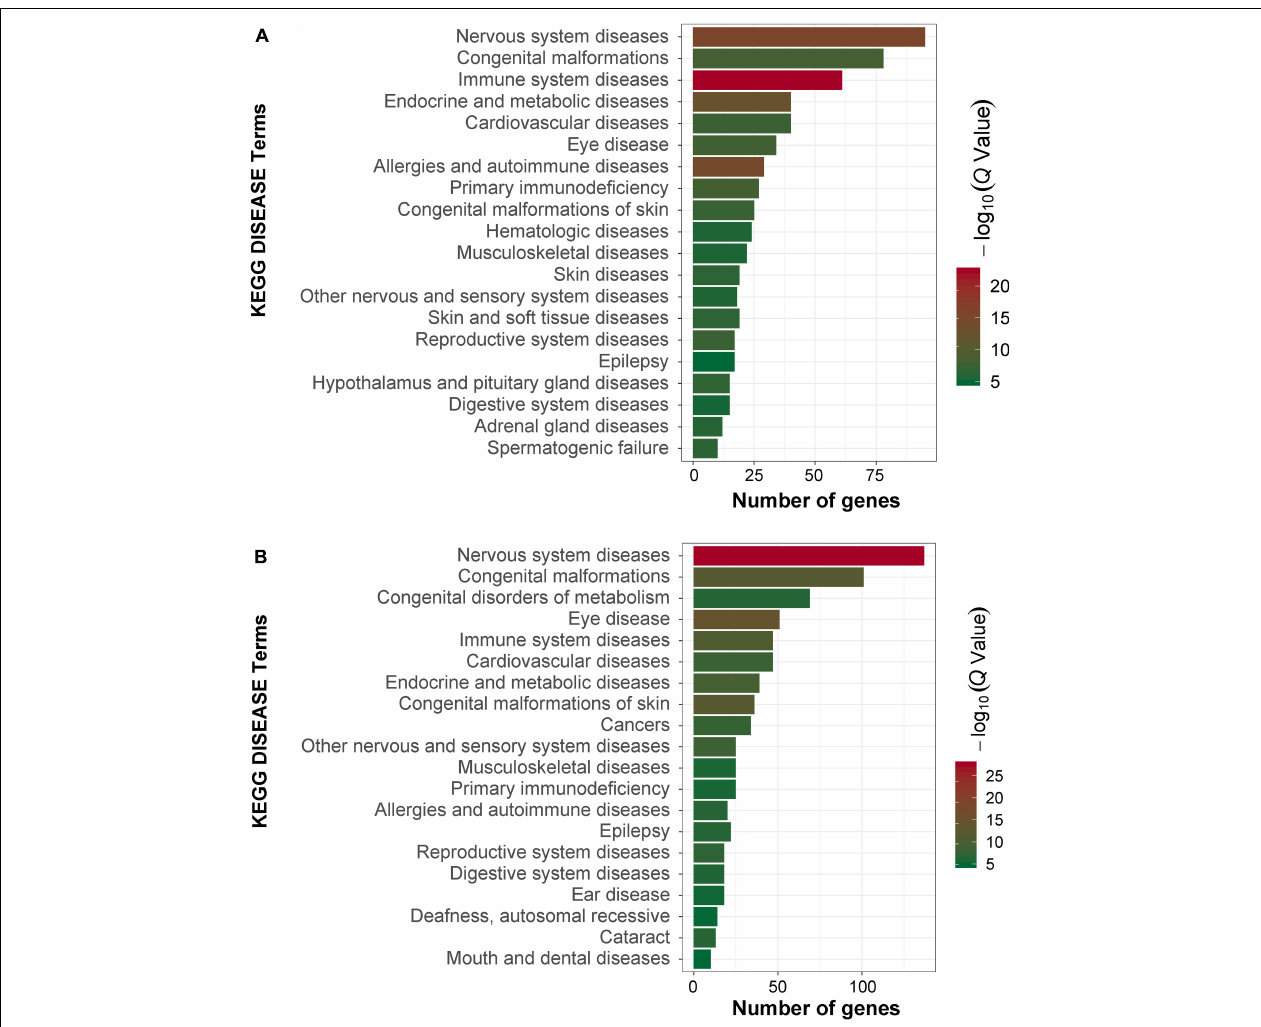
FIGURE 5 | KEGG disease analysis of DEGs in SH-SY5Y cells induced by VZV. (A) KEGG disease analysis of DEGs induced by VZV infection of SH-SY5Y cells for 24 h. (B) KEGG disease analysis of DEGs induced by VZV infection of SH-SY5Y cells for 48 h. The graph shows the first 20 significantly abundant KEGG diseases by using the number of differentially expressed genes as the abscissa and the KEGG term as the